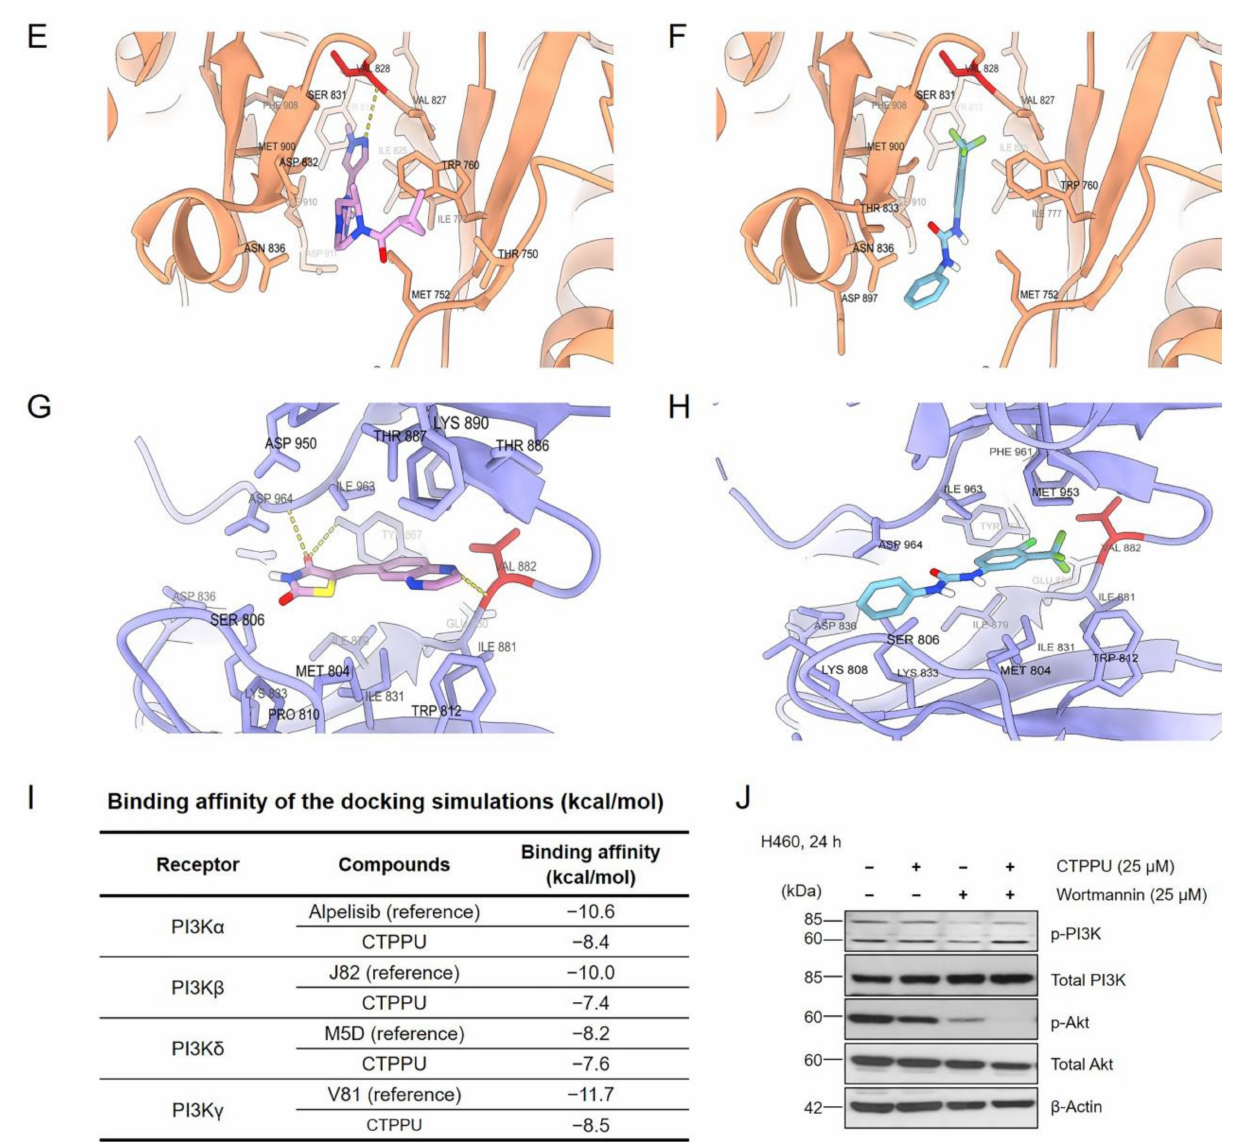
Figure 9. Binding interaction of CTPPU in complex with PI3Ks. Docking interaction profile of PI3Ks inhibitors: ( A ) Alpelisib-PI3K α complex, ( B ) CTPPU-PI3K α complex, ( C ) J82-PI3K β complex, ( D ) CCTPU-PI3K β complex, ( E ) M5D-PI3K δ complex, ( F ) CTPPU-PI3K δ complex, ( G ) V81- PI3K γ complex, and ( H ) CTPPU- PI3K γ . ( I ) The binding affinities of CTPPU against the 4 isoforms of PI3K ( J ) The expression of p-PI3K, total PI3K, p-Akt, and total Akt in H460 were determined by